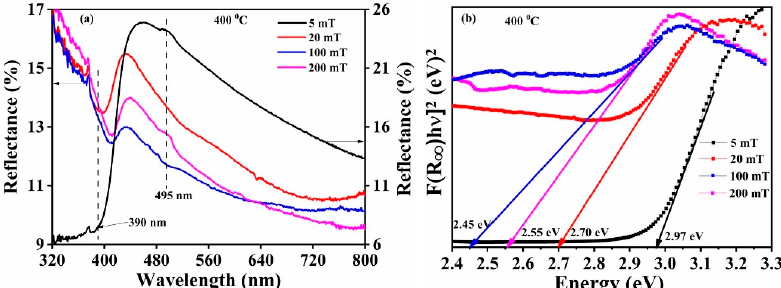
Figure 21. ( a ) DR spectra and ( b ) plots of (F(R ∞ )h ϑ ) 2 versus photon energy of Bi 2 O 3 :Ho 3 + thin films deposited at different O 2 partial pressures (T S = 400 °C).